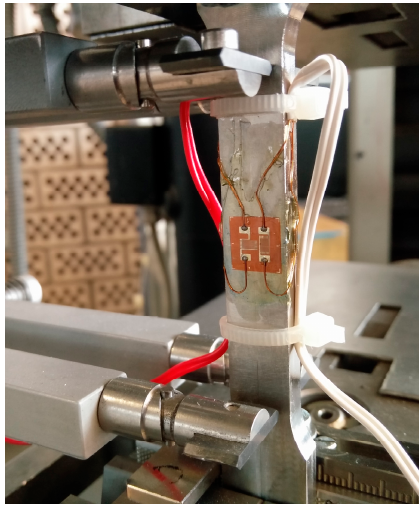
Figure 3. Tensile testing setup with extensometer and strain gauge.